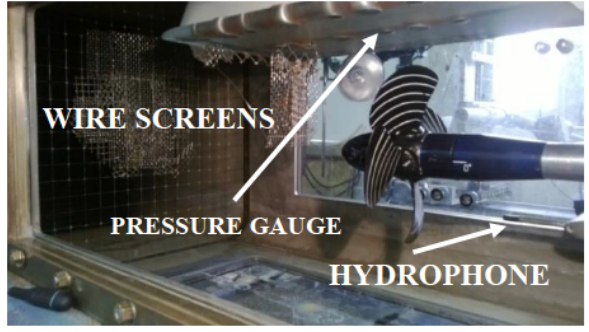
Figure 3: Experimental set-up within the UNIGE cavitation tunnel.